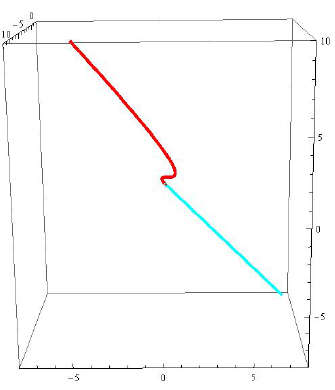
Figure 7. The red (blue) curve is the generalized T ( B ) -associate curve b 1 ( b 2 ) of r .